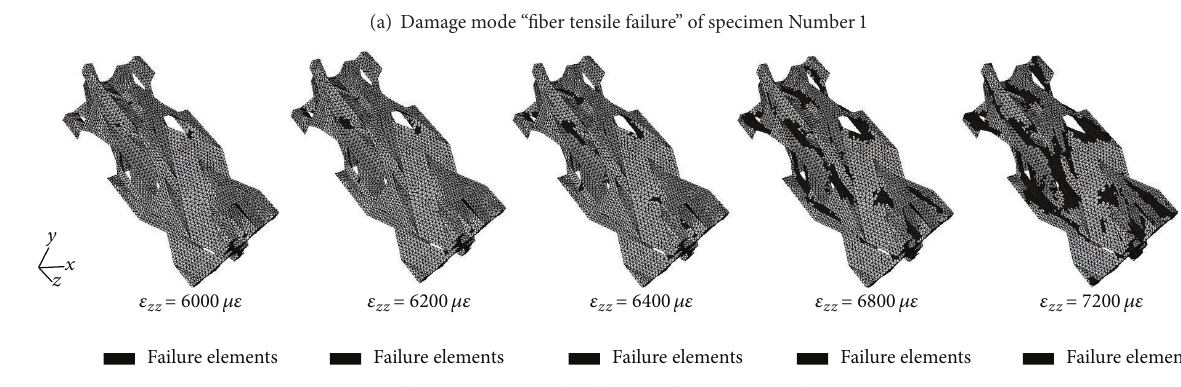
(b) Resin matrix pocket damage of specimen Number 1. Figure 8: Damage evolution of specimen Number 1.